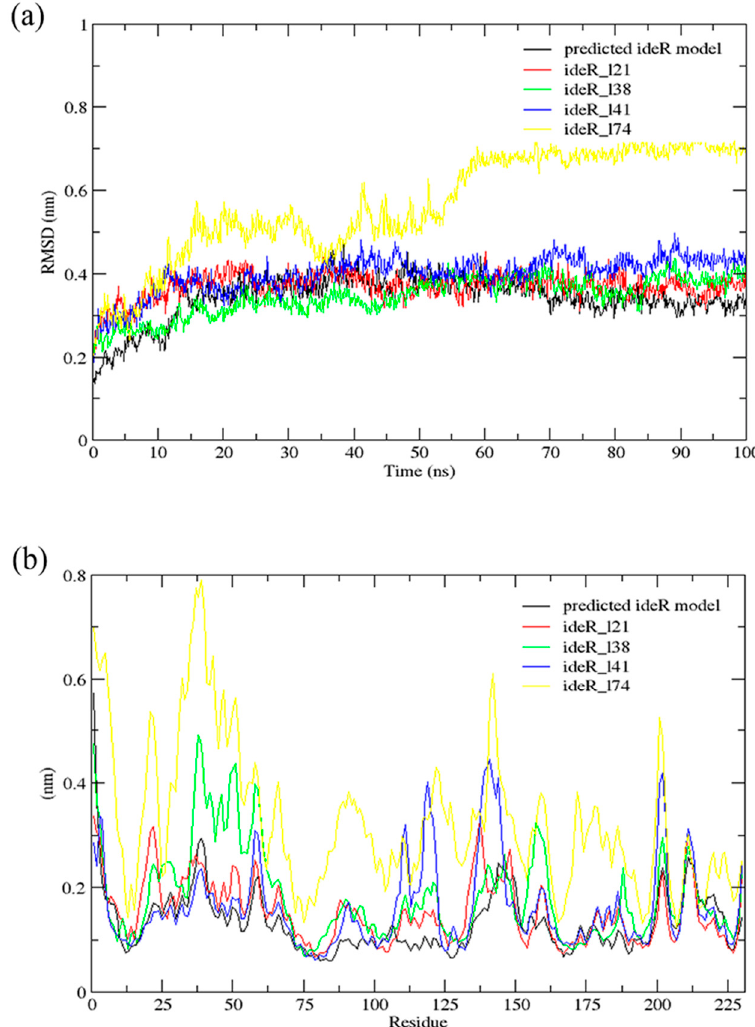
Figure 6. Root Mean Square–Deviation (RMSD) and –Fluctuation (RMSF) graphs of the respective complexes and generated a model of ideR; ( a ) represents the RMSD graph versus time and ( b ) shows the RMSF per residue graphs. Graphs are represented in different colours and indicated in the legend; black–predicted model of ideR, red–ider_l21 (ZINC000095485921-ideR complex), green–ider_l38 (ZINC000014417338-ideR complex), blue–ider_l41 (ZINC000005357841-ideR